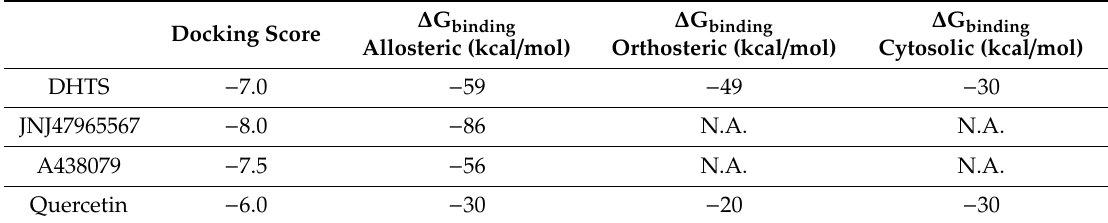
Table 1. Predicted score of P2X7R inhibitors binding. DHTS structural interaction fingerprints clustered that did not cluster with DHTS or